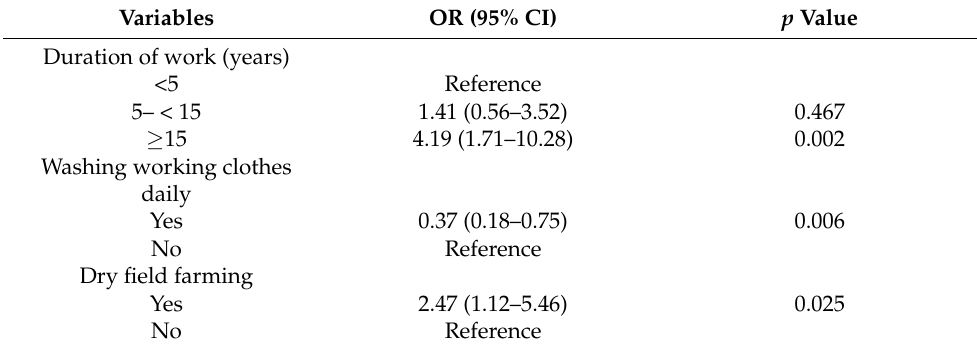
Table 6. Multivariate logistic regression analysis of important variables ( p < 0.10) associated with scrub typhus seroprevalence among National Park Office forestry workers in South